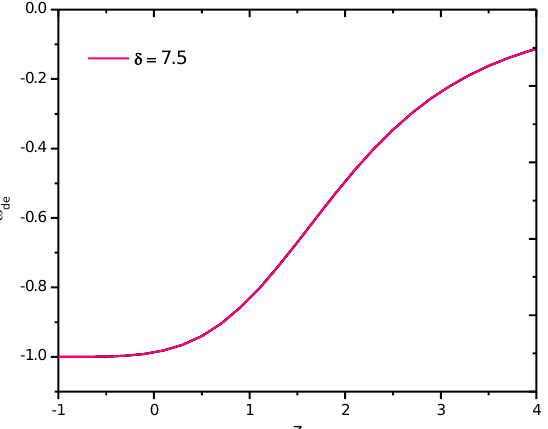
Figure 2. Behavior of EoS parameter of Renyi holographic dark energy density of f ( T , B ) gravity model in Hubble’s horizon cutoff versus redshift for the appropriate choice of constants d = 1.82, β = 6, m = 14, m 1 = 0.001, n = 10 and n 1 = 7.